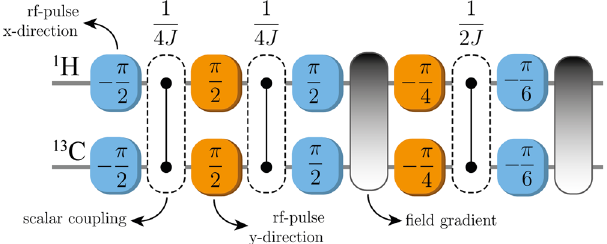
Fig. 4 Pulse sequence for the initial state preparation. The blue (orange) boxes represent x ( y ) local rotations by the angles indicated inside. These rotations are produced by a transverse rf- fi eld resonant with either 1 H or 13 C nuclei, with phase, amplitude, and time duration properly adjusted. The black dashed boxes with connections represent free time evolution under the scalar coupling of both spins. The boxes with a gray gradient represent magnetic fi eld gradients, with longitudinal orientations aligned with the spectrometer cylindrical symmetry axis. All the control parameters are optimized to build an initial pseudo-pure state equivalent to ρ ¼ 00 j i 00 h j with high fi delity ( ≿